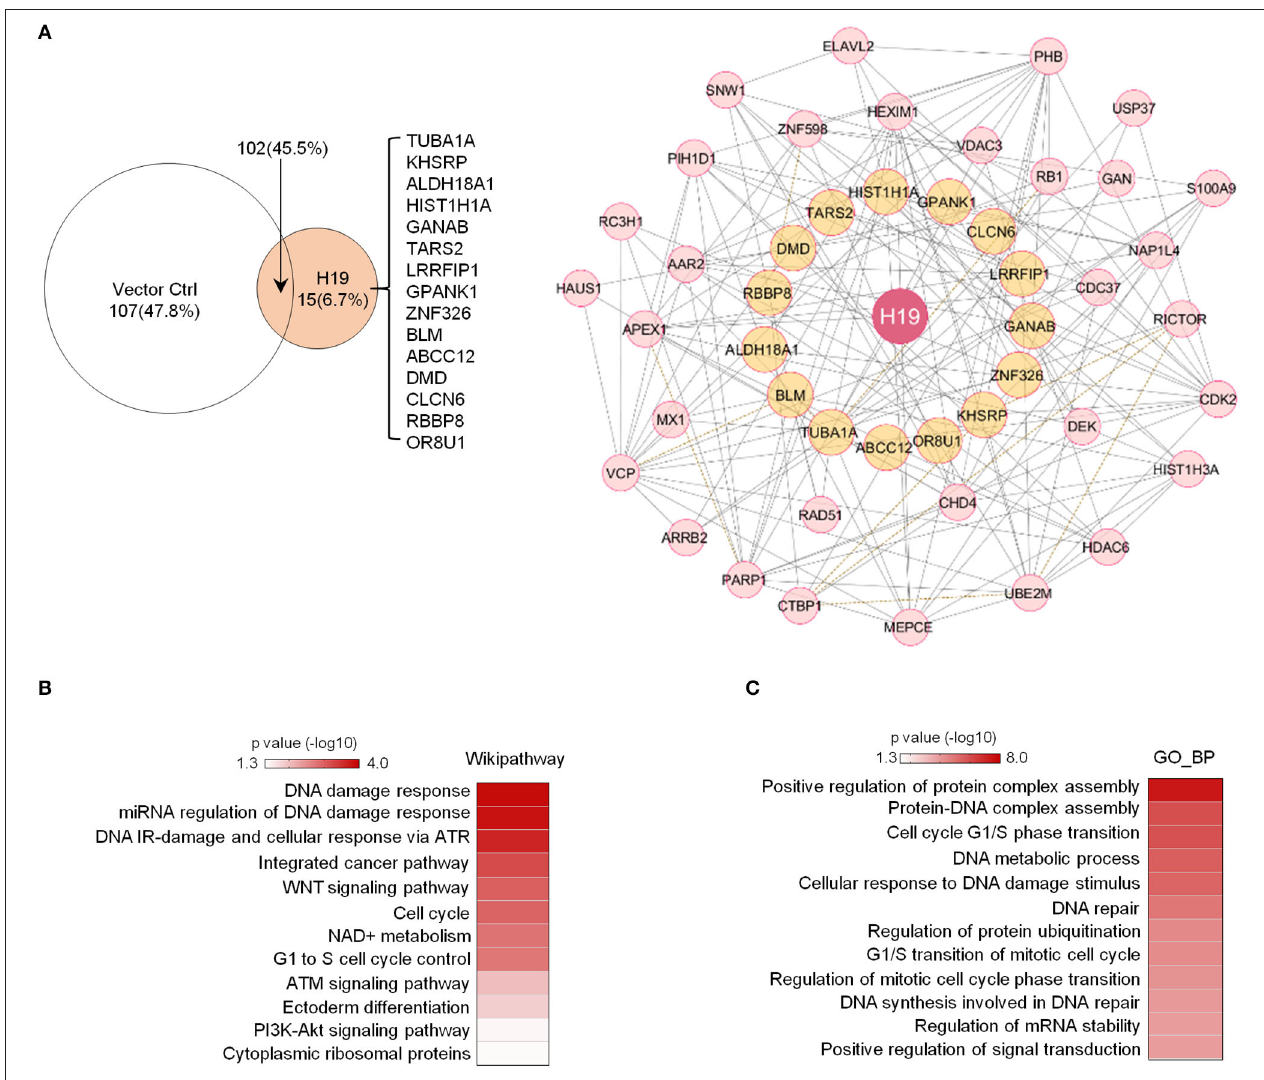
FIGURE 3 | Potential H19 interacting proteins are primarily involved in DNA damage/repair response. (A) Left panel: Mass spectrometry analysis of TetO-FUW-4S1m-H19 streptavidin pull-down proteins identifies 15 unique H19-interacting proteins. TetO-FUW-4S1m vector is used as an S1m pull-down negative control (left). Right panel: The biological protein-protein interaction network based on H19-interacting proteins (orange, n = 15) and expanded to include genes (pink, n = 31) connected to at least two H19-interacting proteins is constructed in Cytoscape using the Biogrid human database. A solid line indicates physical interactions. A dashed line indicates genetic interactions. (B,C) Heatmaps representing p-values of enriched genesets ( p ≤ 0.05) among the H19-interacting protein complex genes ( n = 47) by Wikipathway (B) and GO_BP (C)